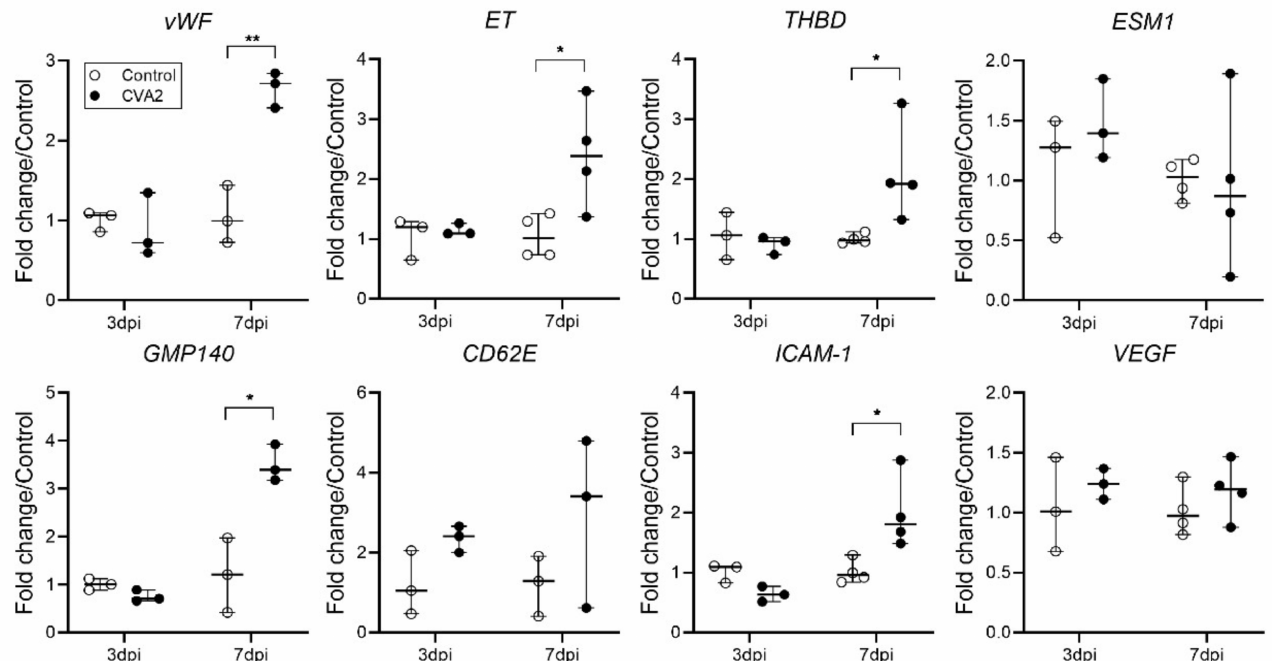
Figure 4. Effect of CVA2 infection on the mRNA levels of biomarkers of vascular endothelial cell dysfunction. qPCR was conducted to measure the expression levels of the related genes in lung tissues (3 dpi and 7 dpi) normalized to β -actin expression level. n = 3 or 4 per group, data represent median with range. * p < 0.05; ** p < 0.01 vs. control. All the experiments were repeated at least three